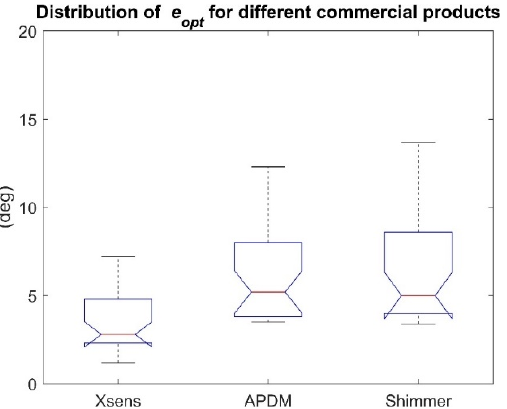
Figure 4. Commercial product effect: Xsens, APDM, and Shimmer e opt distributions (10 SFAs × 3 rotation rates). It is possible to assess that APDM and Shimmer distributions statistically differ from that of Xsens. Table 7. Mean ± STD Errors for Each Commercial Product Scenario.